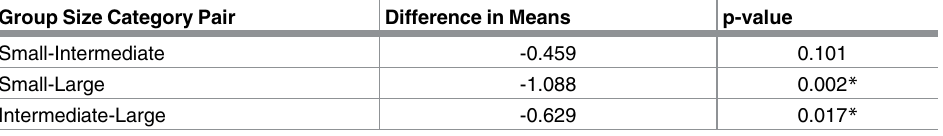
Table 2. Post-hoc comparison of mean log-transformed feather corticosterone (pg/mg) according to categorical group sizes (n = 50).